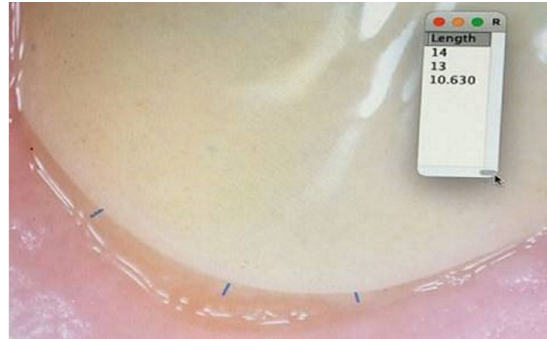
Fig. 8 Image of buccal side showing the margin analysis by the imageJ software in three points